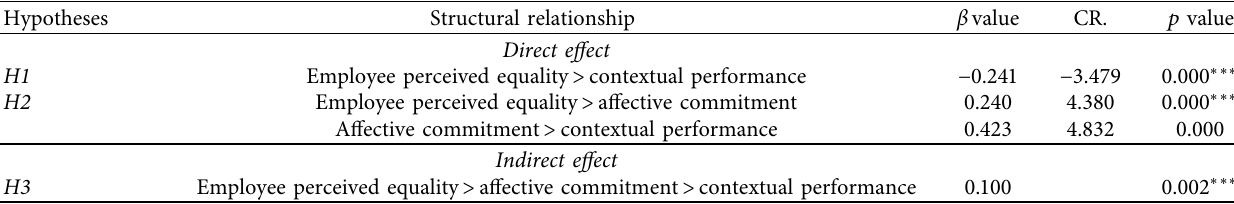
Table 7: Summary of hypotheses testing results.